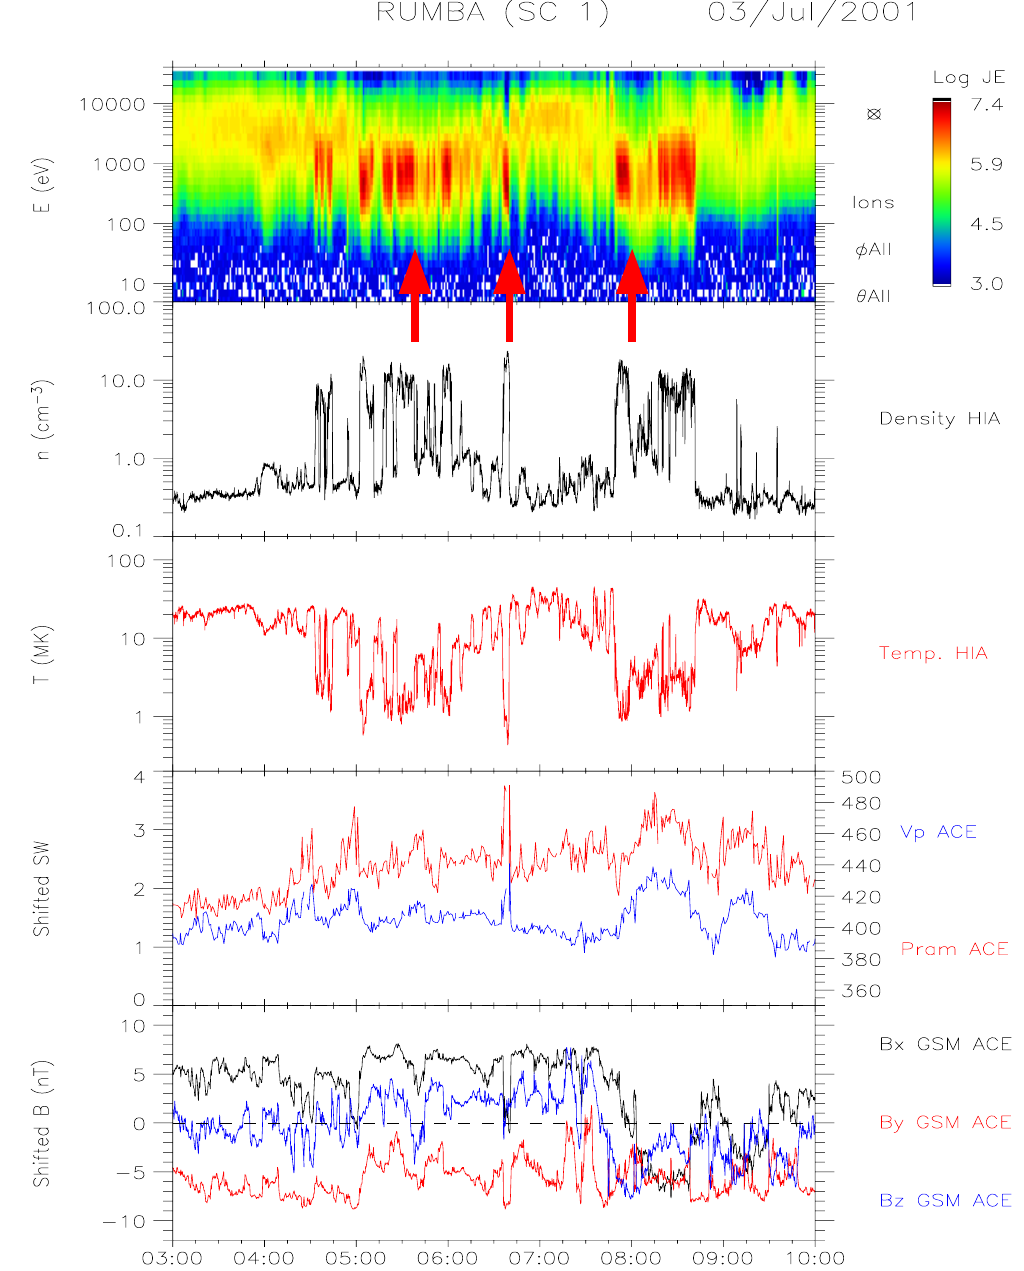
Fig. 1. Overview plot of Cluster spacecraft 1 (sc1) and ACE (lagged) magnetic field and plasma data on 3rd of July 2001 between 03:00– 10:00 UT. The panels from top to bottom show i) omni-directional energy flux spectrogram for ions, ii) ion density, iii) ion temperature iv) proton velocity and dynamic pressure at ACE, vii) and magnetic field at ACE. Red arrows mark the start of the intervals when magnetosheath energy ions are observed in tenuous